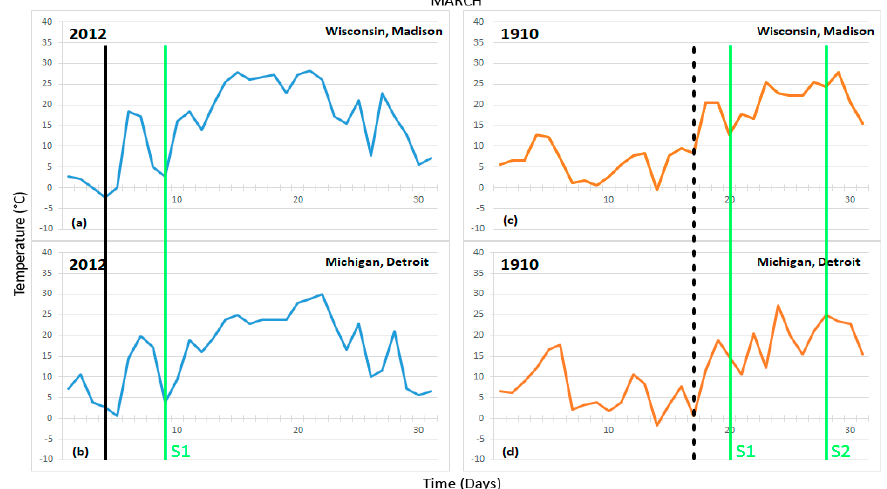
Figure 9. The famous heat waves of March 2012 ( a , b ) and March 1910 ( c , d ) in the Northeast United States occurred in association with ongoing strong magnetic storms, as shown by the normal green lines (S and S1, S2, respectively). Temperatures are shown in Madison, Wisconsin, ( a , c ) and in Detroit, Michigan ( b , d ). The disturbed space conditions during the March 1910 and March 2012 heat waves are consistent with solar activity as a candidate external stimuli of the enhanced